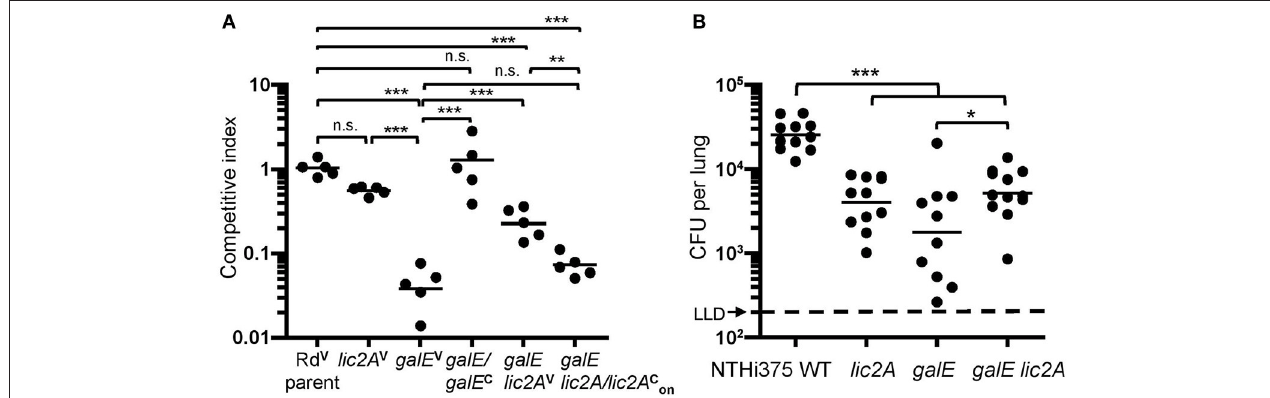
FIGURE 9 | Deletion of lic2A in the galE mutant background partially rescues attenuation of the galE mutant for lung colonization in both Rd and NTHi strains. H. Influenzae Rd or NTHi 375 and isogenic mutants in their respective background strains recovered from lungs of C57BL/6 mice 24h after intranasal inoculation. (A) H. influenzae Rd strains as described in Table 1 were co-inoculated with an equal amount of an H. influenzae reference strain expressing lacZ (RdLacZ) and recovered from mice ( n = 5). Ratio of CFU of the experimental strains (LacZ–) to competitor strain (LacZ + ) is reported as the competitive index (CI). Bars represent the geometric mean ratio of CFU of each designated strain relative to the LacZ + reference strain. CI fold differences of parent vs. each of the mutants: lic2A V (1.9x), galE V (24x), galE lic2A V (4.3x), and galE lic2A / lic2A C on (14x) and between galE lic2A V vs. each of the mutants: galE V (5.5x), galE lic2A / lic2A C on (3.3x). (B) NTHi 375 wild-type (WT) and isogenic deletion mutants recovered from mice ( n = 10–12). Bars represent the geometric mean CFU per lung. LLD, lower limit of detection. Fold differences in mean CFU recovered for WT vs. each of the mutants: lic2A (5.5x), galE (6.9x), and galE lic2A (4.3x) and between galE vs. galE lic2A (1.6x). Differences were evaluated via one-way ANOVA with Bonferroni’s multiple comparison test of log-transformed values (* p < 0.05; ** p < 0.01; *** p < 0.001; n.s., not statistically significant).